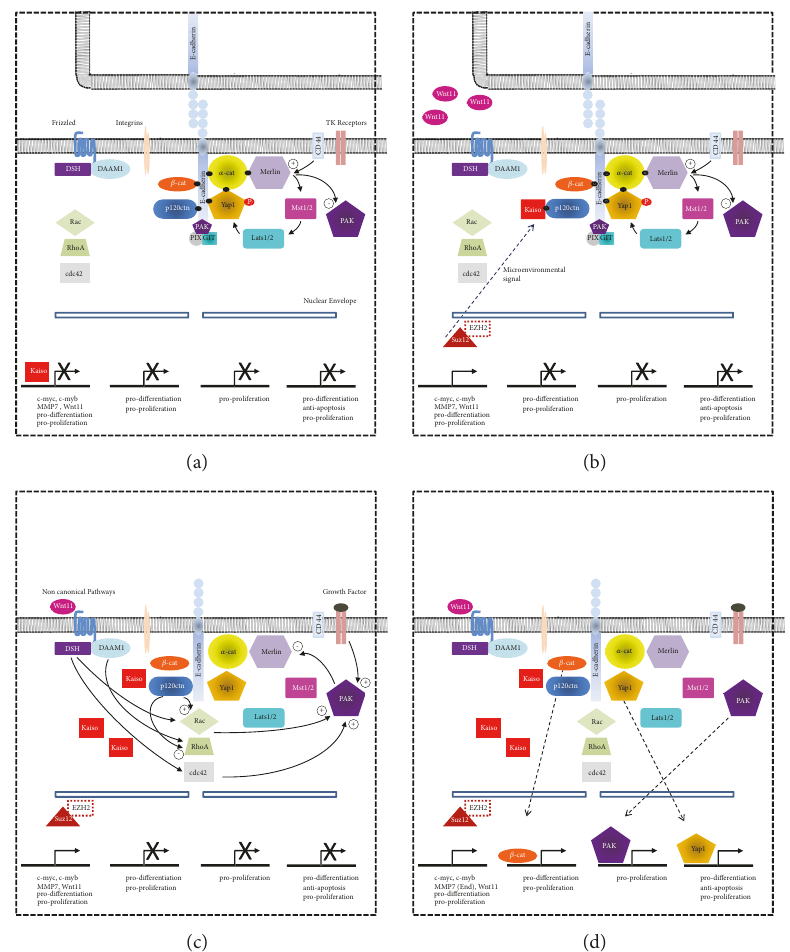
Figure 4: The embryonic model of cancer in the new context of adherens junctions. (a) E-cadherin as a functional platform that acts as both anchoring components of the canonical and noncanonical Wnt pathways and the Hippo signaling pathway and interacting with NF2/Merlin, Rho GTPases, and PAK-PIX-GIT. E-cadherin and 𝛼 -catenin act as direct regulators of YAP1 and its homologue TAZ [66–68]. The canonical Hippo pathways [69], in vertebrate cells, act sequentially with MST1/2 and Lats1/2 [70, 71] to regulate the phosphorylation state of Yap1 (P, phosphate).PhosphorylationofYAP1byLat1/2mediatessequestrationofYAP1inthecytoplasmwhileunphosphorylatedYAP1istranslocated into the nucleus, where it drives the expression of genes that promote cell proliferation [71]. 𝛼 -catenin depletion or deletion in keratinocytes shifts Yap1 into the nucleus and elevates nuclear Yap1 activity, thereby favoring cell proliferation. NF2/Merlin plays an inducer role (+) of the contact inhibition by the interaction with cadherins and catenins [72–76]. When activated, NF2/Merlin acts as a growth suppressor by inducing contact inhibition. An inducer signal is also obtained from CD44. There is evidence that Pak1 and Merlin interactreciprocally upon one other, such that Merlin also inhibits Pak1 function and suppresses the activation and the recruitment of Rac1 to the plasma membrane, which may be part of the mechanism by which Merlin regulates contact inhibition [73, 77–81]. Rho GTPases can be activated by growth factor-activated receptor or in response to cell-cell adhesion complex or cell-matrix adhesion receptors [82]. Rho GTPases participate in bidirectional signaling with both cadherins [83] and integrins [84]. In this initial context, Kaiso is found in the nucleus of the cell. (b) Kaiso in response to microenvironment signals is translocated to the cytoplasmic compartment. The immediate effect is to increase the expression of Wnt11 and Suz12 and the PCR2 complex would be involved in the repression of E-cadherin. Cytoplasmic Kaiso interacts with p120ctn and begins to destabilize the cell-cell adhesion complex. (c) The binding of Wnt to the Frizzled receptor leads to activation of Rho GTPases and PAK. p120ctn is a positive regulator of Rac1 [85] and thereby contributes to an alternative regulation of the recruitment of Rac1 to the cell-cell junctions. PAK represses NF2/Merlin and would contribute to destabilize the cell-cell adhesion complex, releasing Yap1, 𝛽 -catenin, and the PAK-PIX-GIT complex. (d) YAP1, Pak1, and 𝛽 -catenin, in the nucleus of the cell, activate proteins involved in processes such as cell proliferation and cell differentiation. DSH (Dishevelled); DAAM1 (Dishevelled Associated Activator of Morphogenesis 1); RAC, RhoA, and cdc42 (GTPases); p120ctn (p120 catenin); 𝛽 -cat ( 𝛽 -catenin); 𝛼 -cat ( 𝛼 -catenin); YAP1 (Yes-associated protein-1); PAK (p21-activated kinase); PIX (p21-activated kinase- (PAK-) interacting exchange factor); GIT (G-protein-coupled receptor-kinase-interactingprotein); Lats1/2 (Large Tumor Suppressor 1 and 2, also known as Warts); Mst1/2 (Mammalian Sterile20-like 1 and 2); TK receptors (Tyrosine kinase receptors); CD44 (receptor for hyaluronic acid); Frizzled (family of G protein-coupled receptor proteins that serves as receptors in the Wnt signaling